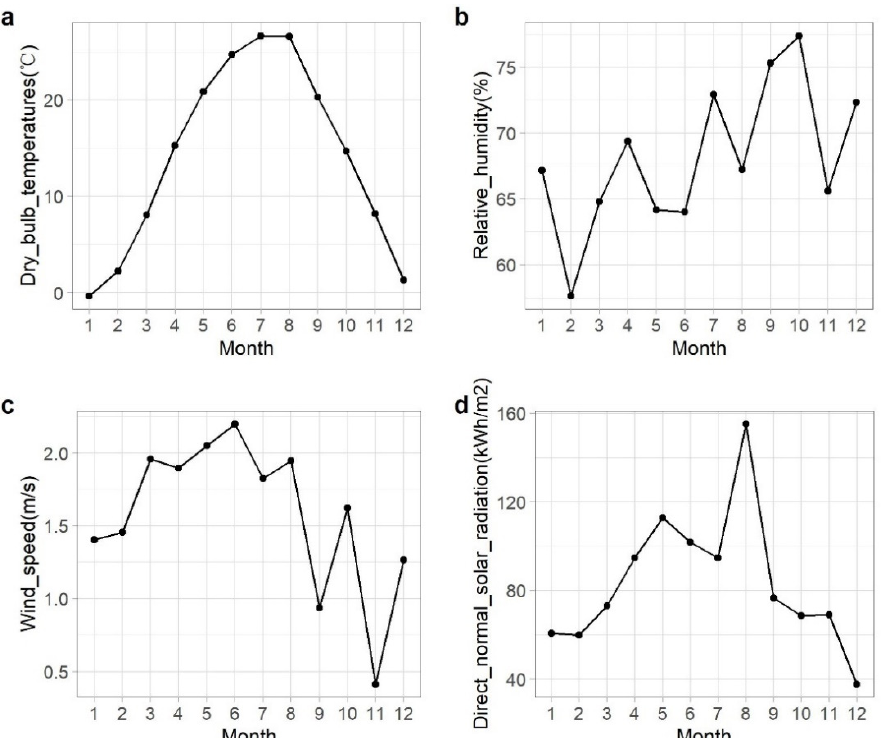
Figure 2. Monthly average weather data of Xi’an: ( a ) Dry bulb temperature; ( b ) Relative humidity; ( c ) Wind speed; ( d ) Direct normal solar radiation.